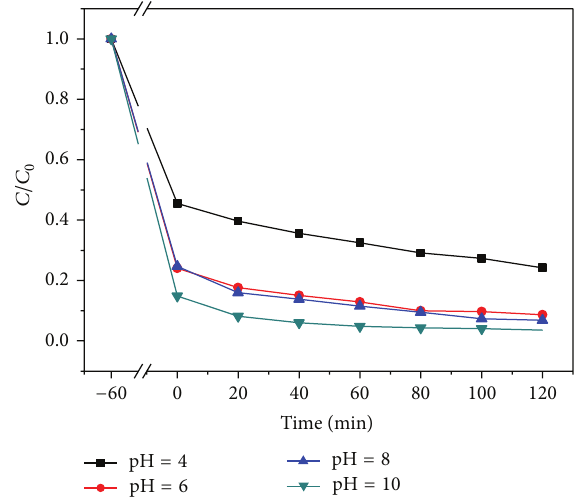
Figure 6: The effect of pH on the photocatalytic degradation